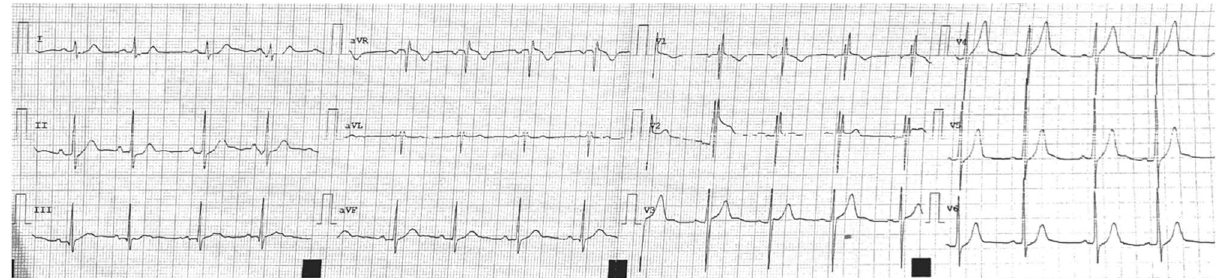
Figure 2. Resting ECG performed during sports screening. We can see Sokolow–Lyon Criteria for left ventricular hypertrophy (S wave in V1 + R wave in V5 or V6 ≥ 36 mm in male) and pathological J-ST depression in V6. There is possibly a J-ST depression in leads I and II, but we cannot be sure because of the quality of the resting ECG available. Finally, there is partial right bundle branch block (rSR’ pattern in V1–V2), but it is not a pathological finding.